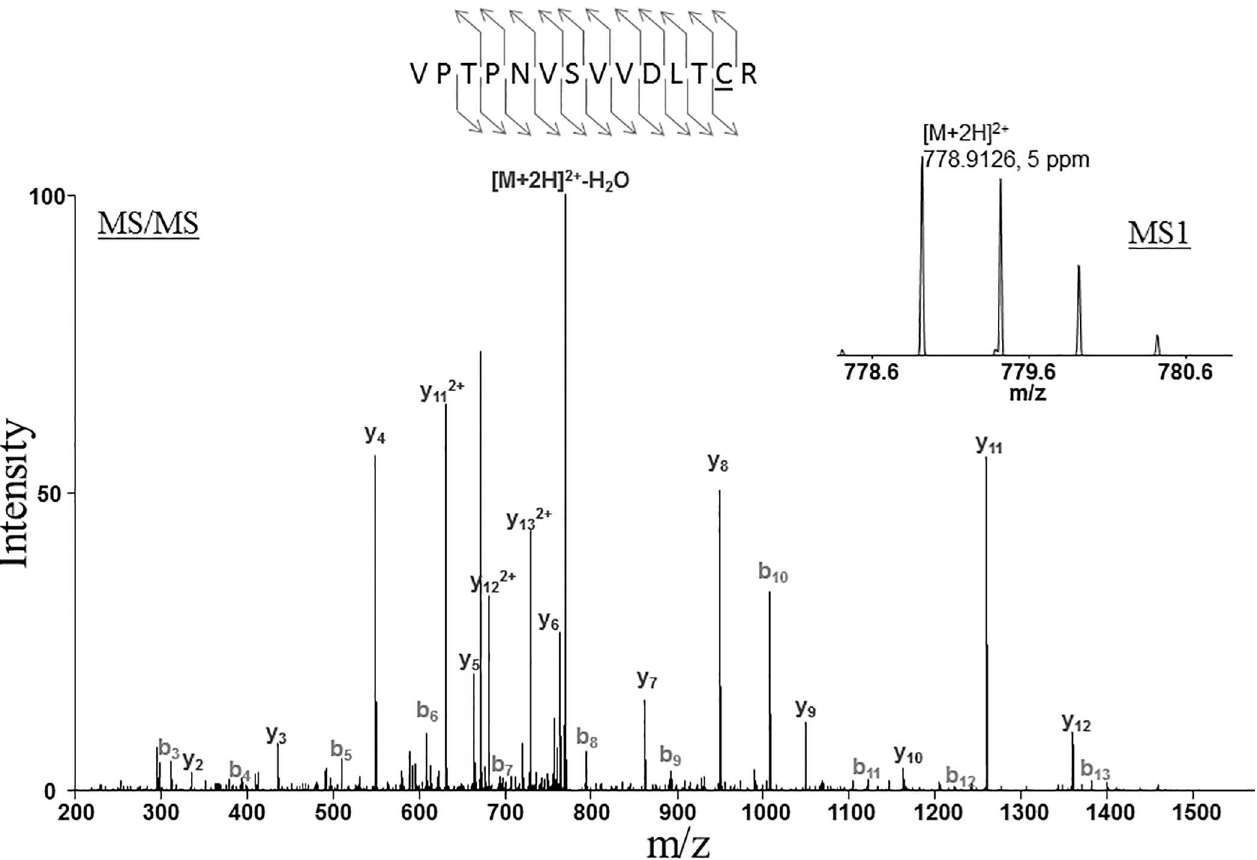
Fig 3. Identification of Glyceraldehyde-3-phosphate dehydrogenase by LC-MS/MS. The peptide was detected as doublycharged with a mass-to-charge ratio of 778.9126, which represents an error of 5 ppm. The tandem mass spectrum matched the followingsequence, VPTPNVSVVDLTCR. The detectionwas made with Mascot with ion score